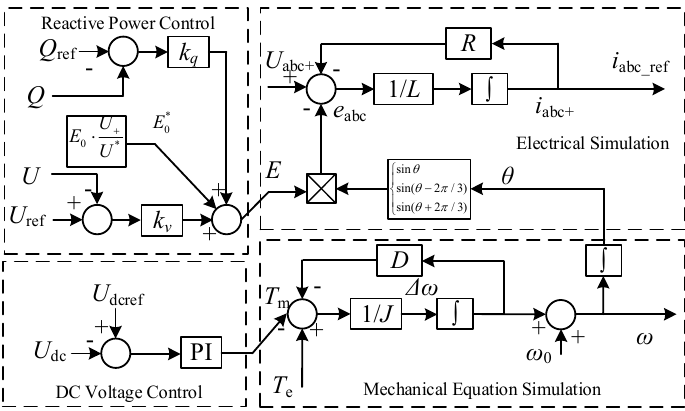
Figure 6. VSM control block diagram with no negative sequence current.